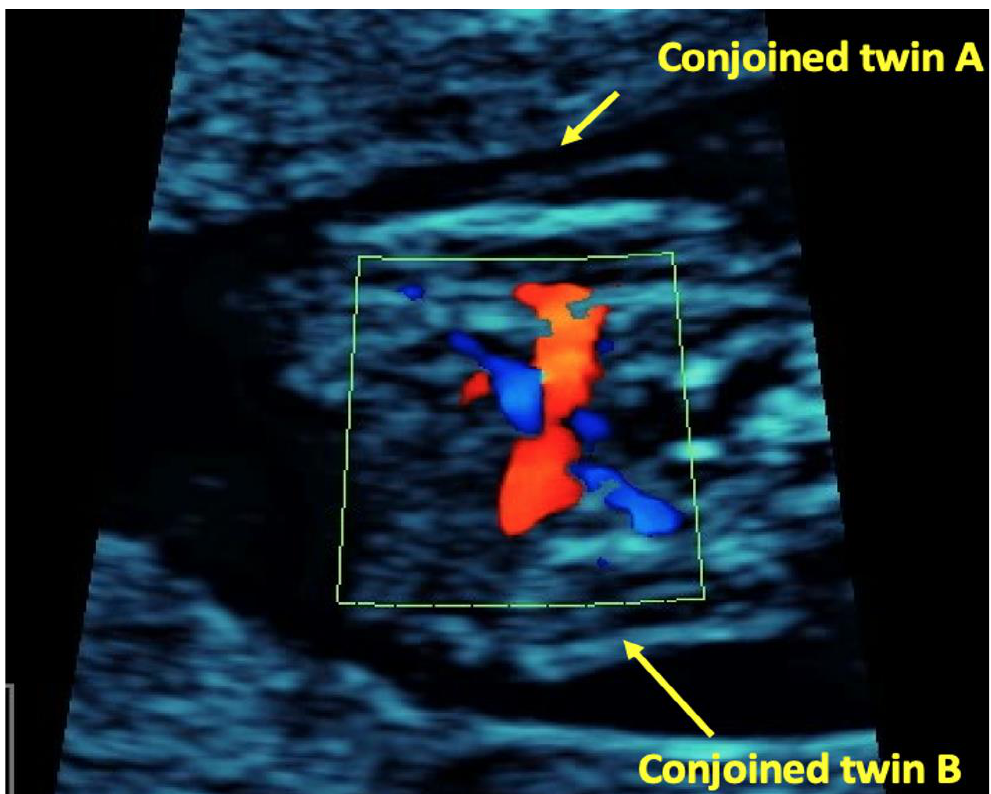
Figure 3. Conjoined twins, transverse plane Color Doppler showing fused cardiac structure.